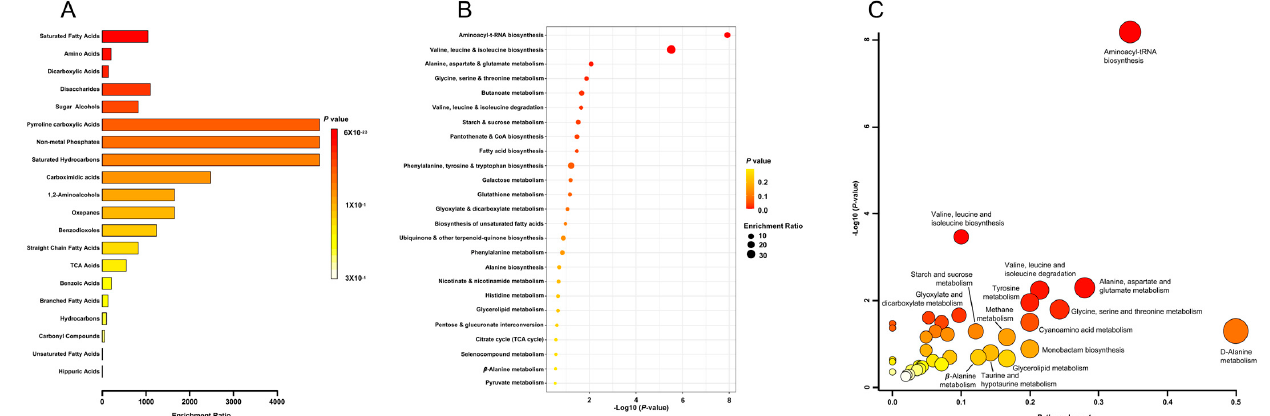
Figure 2. Metabolite sub-class enrichment analysis ( A ), metabolic pathway enrichment ( B ) and metabolic pathway impact analysis ( C ) of L. plantarum metabolites (LPM). Untargeted chemical fingerprinting of LPM was performed using GC-MS after sample derivatization using silylation. Identified compounds are enlisted in Supplementary Table S1. The compounds and corresponding abundance scores were utilized in MetaboAnalyst 5.0 to identify the chemical class and pathway enrichments. Relevant additional data are provided in the supplementary document.